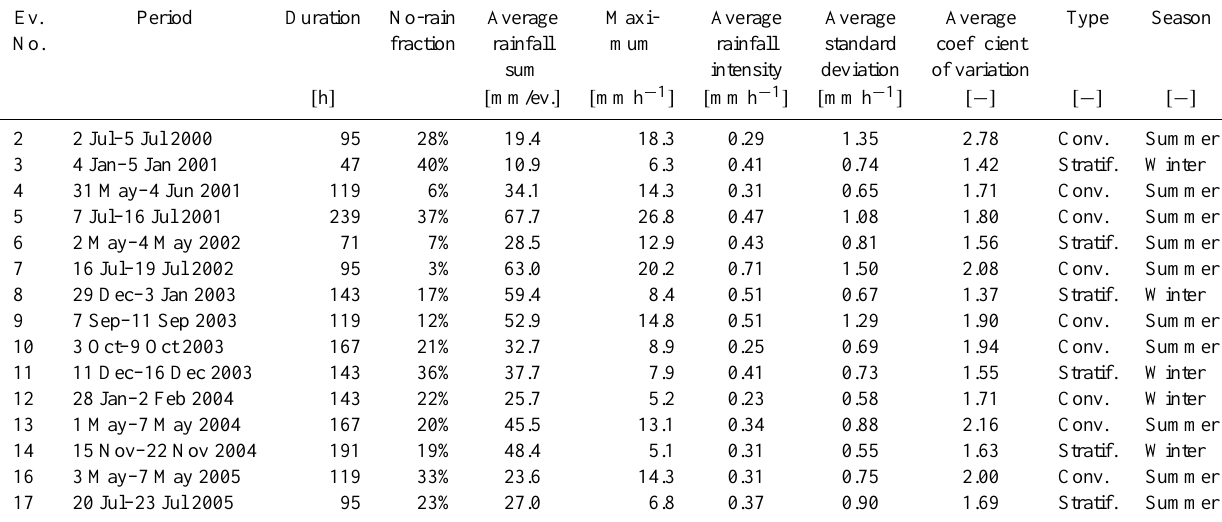
Table 1. Precipitation statistics of the selected events with hourly time step data; standard deviation, coefficient of variation and no-rain fraction are spatially calculated and averaged over